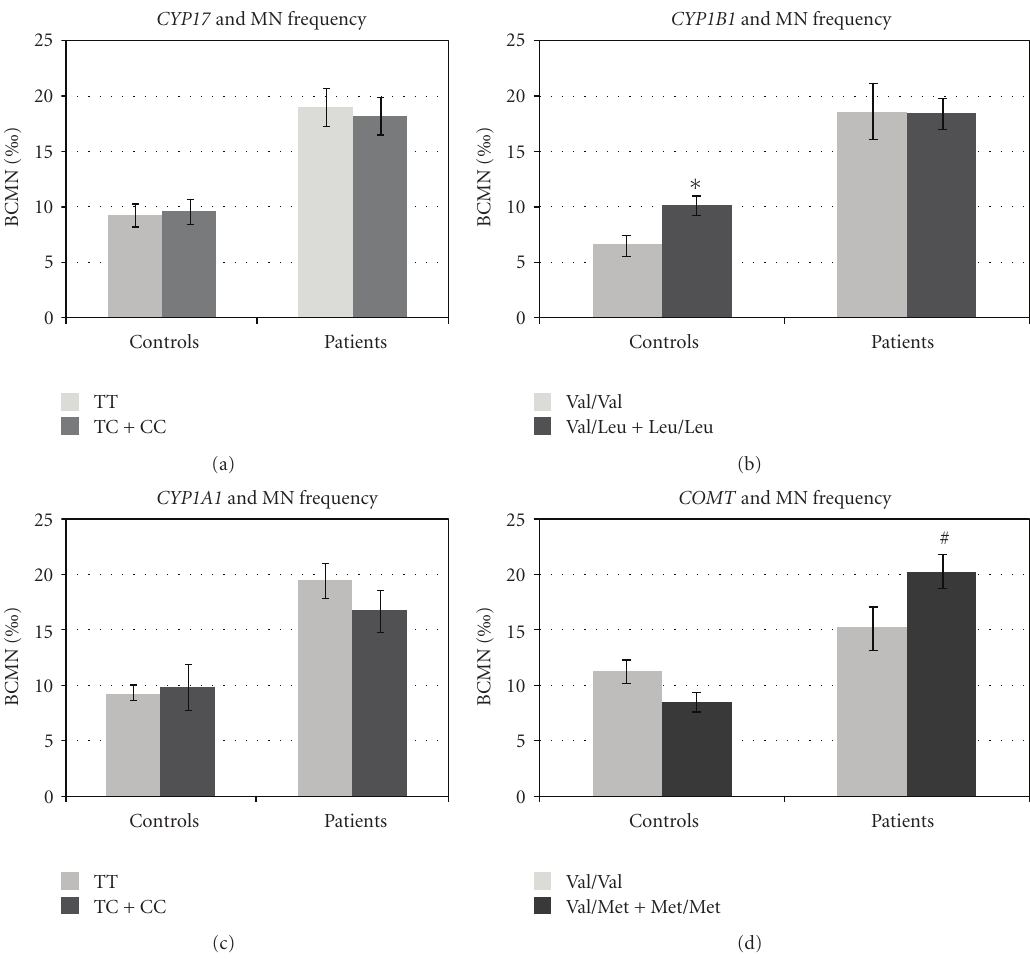
Figure 2: Frequency of BCMN in untreated BC women and healthy controls considering the presence of estrogen-metabolizing genes polymorphisms (a) CYP17 , (b) CYP1B1 , (c) CYP1A1 , and (d) COMT . A total of one thousand binucleated cells were analyzed for MN count in each of 62 BC patients and 62 age-matched controls. Bars represent standard error of mean; ∗ P < . 005 significantly di ff erent from